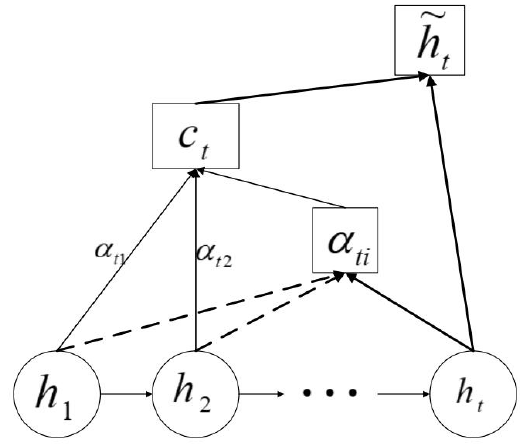
Fig. 5. Temporal attention mechanism.